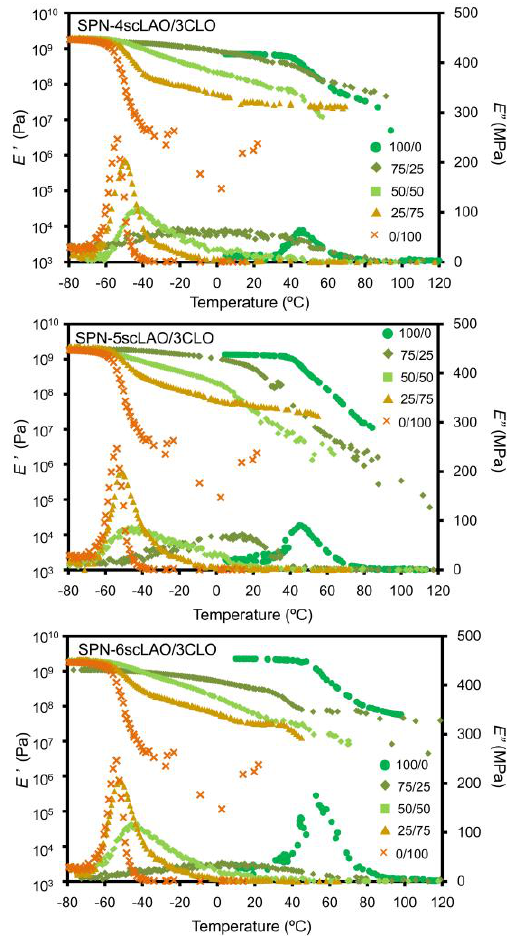
Figure 7. DMA curves of SPN- m scLAO/3CLOs 100/0, 75/25, 50/50, 25/75 and 0/100 ( m = 4, 5 and 6).